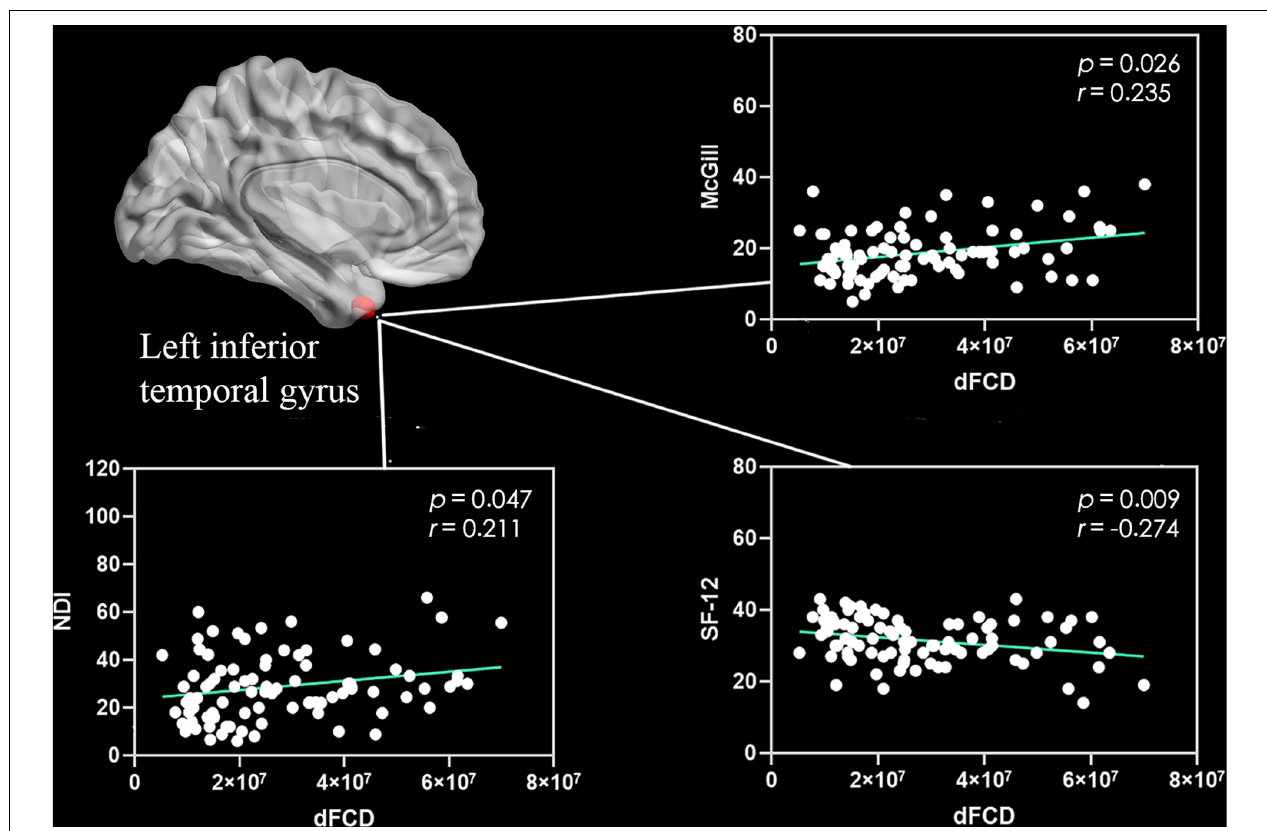
FIGURE 4 | Correlation between dynamic functional connectivity density (dFCD) variability in the left inferior temporal gyrus and right inferior temporal gyrus with McGill scores, neck disability index (NDI) scores, and SF-12 scores of the CNP Group. NDI, neck disability index; SF-12, short form 12